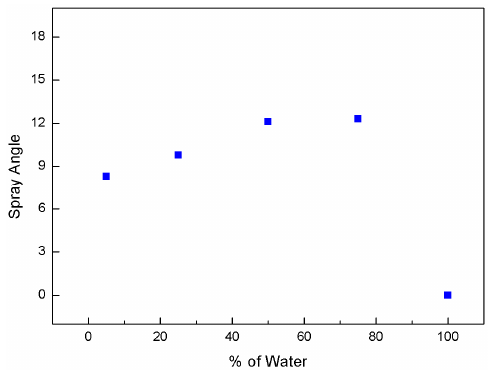
Figure 4. Change in spray angle with respect to water fraction at 65/40 bar.